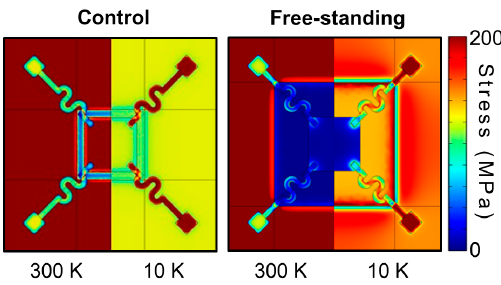
Figure 3. Finite-element analysis mapping the calculated stress distributions for the control and free-standing GaMnAs microsheets for T = 300 K and 10 K.